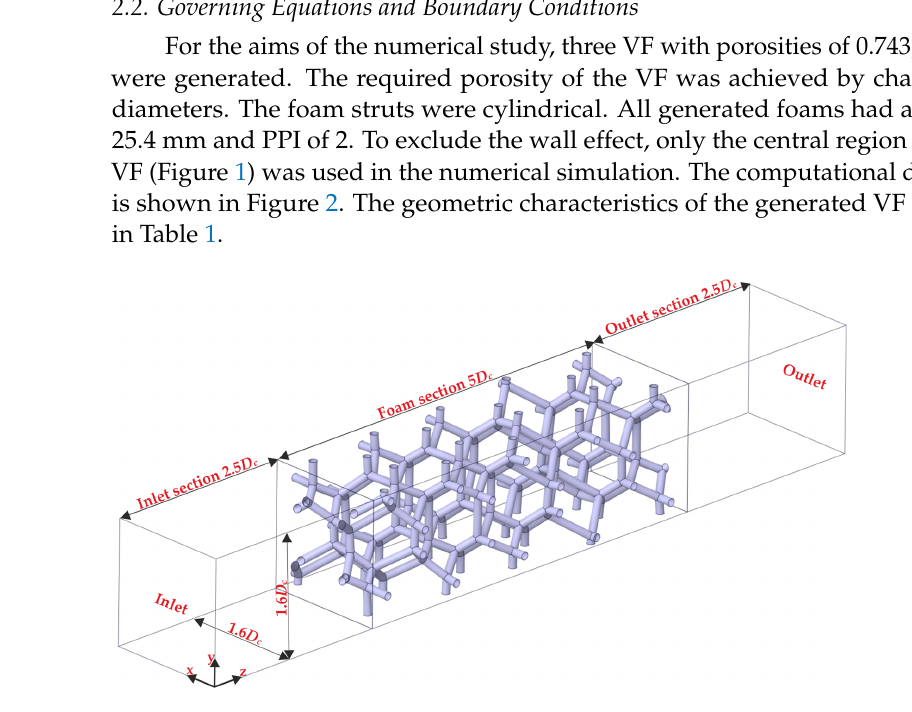
Figure 2. Computational domain of the VF. Table 1. Geometrical characteristics of the generated VF.